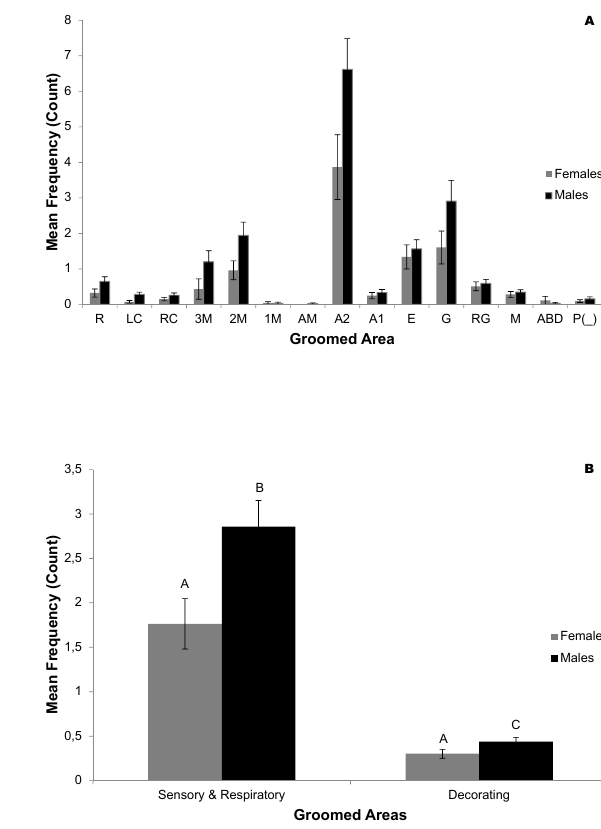
Figure 3. Frequency of grooms, with standard error bars, per body region during 30-min isolation observations (N=142; N=89 males; N=53 females) for males and females. A. Mean frequency of grooms for males and females for body regions (males: H =248, p<0.001; females: H =101, p<0.001); x-axis organized by anterior body regions on the left to posterior body regions on the right.